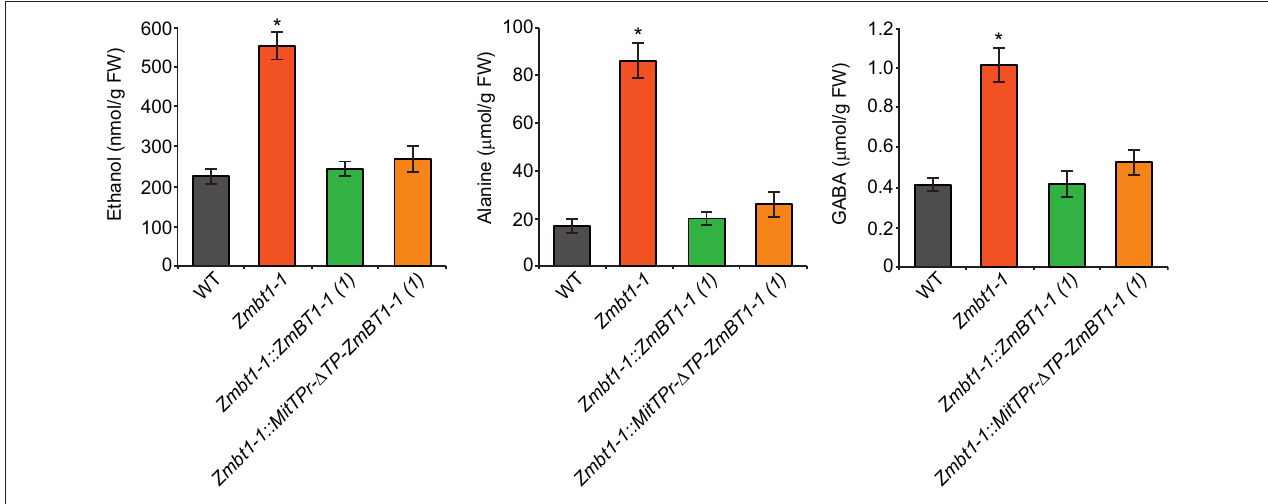
FIGURE 7 | Lack of mitochondrial ZmBT1-1 promotes the accumulation of high levels of ethanol, GABA, and alanine. The graphics represent the contents of the metabolites indicated in 24 DAP endosperms from WT, Zmbt1-1, Zmbt1-1::ZmBT1-1(1), and Zmbt1-1::MitTPr- 1 TP-ZmBT1-1(1) seeds. Values represent the mean ± SD of determinations on four independent samples. Asterisks indicate significant differences based on Student’s t -tests. ( P < 0.05, Zmbt1-1 mutants vs. WT).